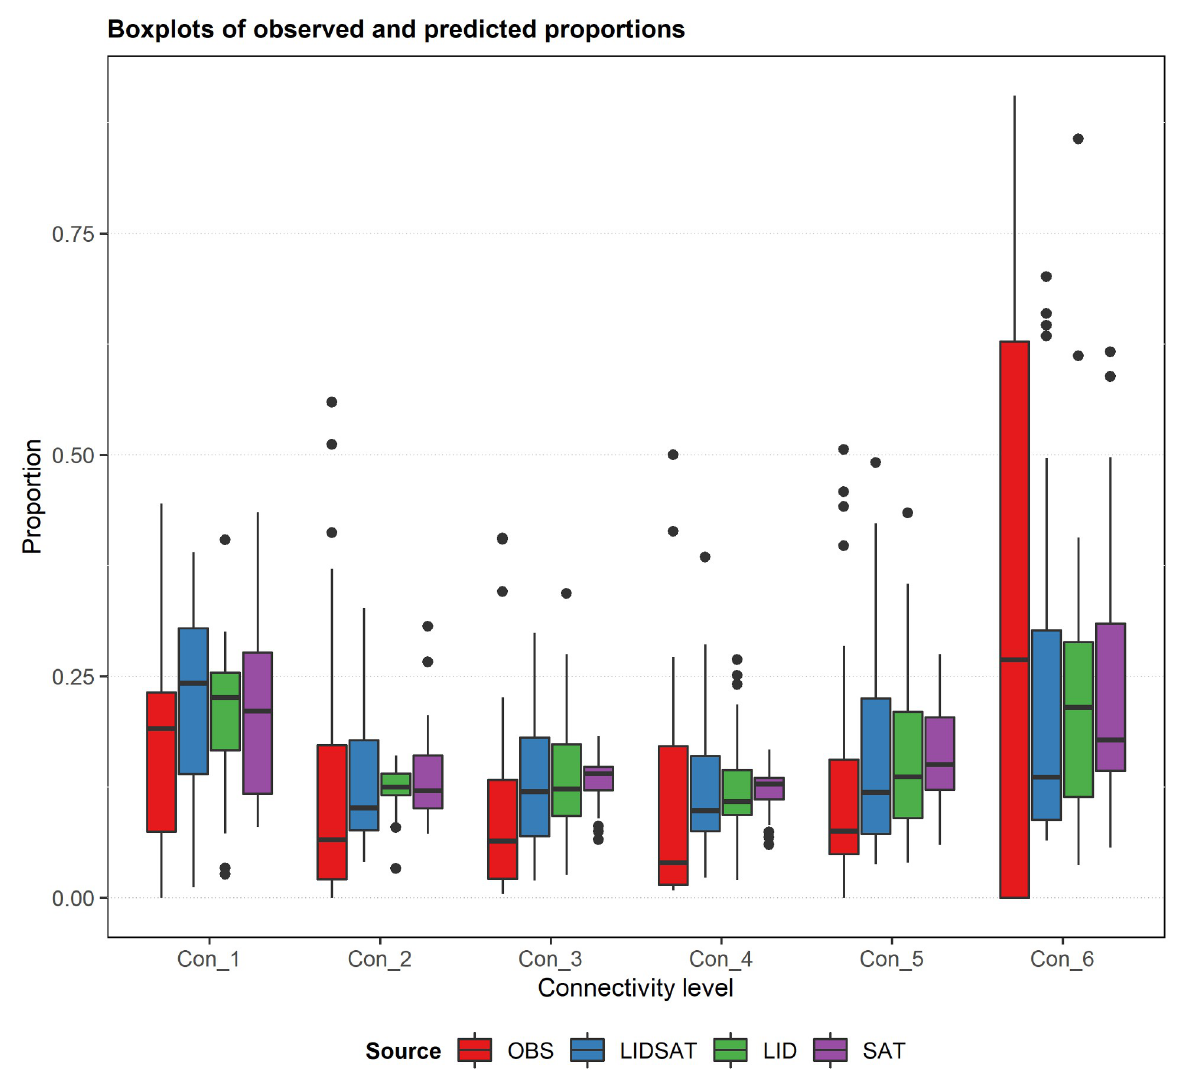
Fig 6. Boxplots of observed and predicted proportions of the six connectivity levels. Predictions were obtained using the final LIDSAT, LID, and SAT models fitted to the entire